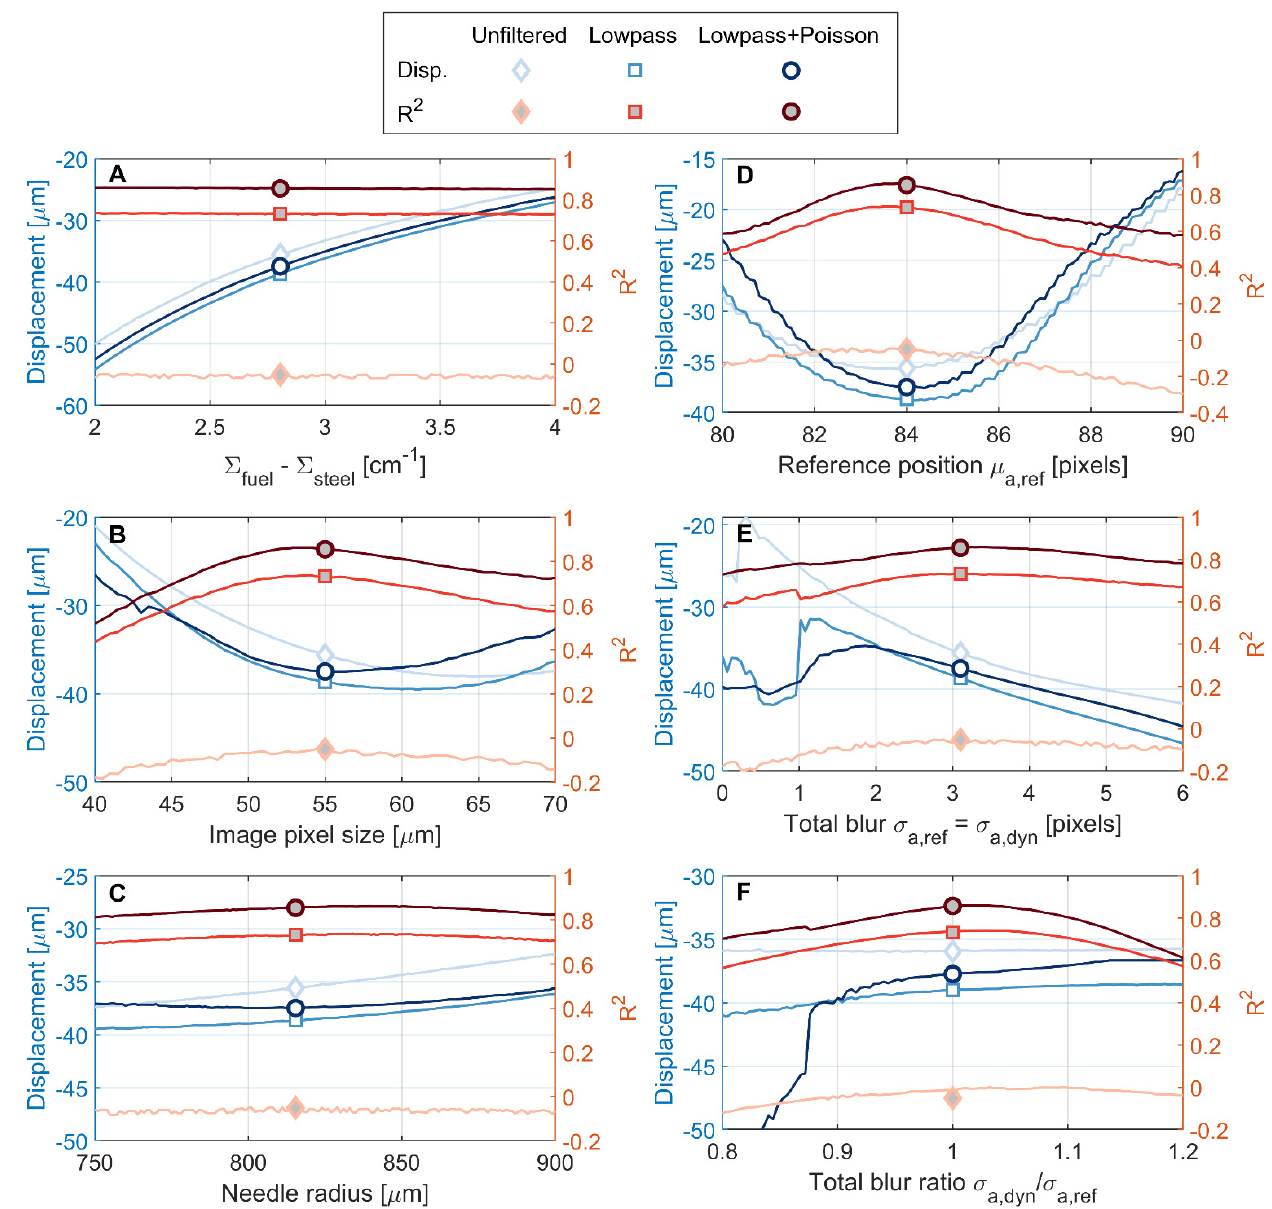
Figure A4. Effect of fit parameters on displacement prediction and fit quality. Fit parameters were independently varied at a high-displacement condition ( t = 2.27 ms). Symbols indicate fit parameters chosen for the time-series displacement fitting. ( A ) Attenuation coefficient difference has a large effect on predicted displacement but no impact on R 2 . Image pixel size ( B ) and injector needle radius ( C ) together set the scaling used in the model, and the peaks in R 2 for both parameters are near the values obtained from scale measurements with low sensitivity in predicted displacement at those values. ( D ) Reference position (nominal needle center) has clear R 2 peak and low sensitivity in predicted displacement at same value. ( E ) With reference and dynamic total blur set as equal, the filtered cases exhibit an R 2 peak and mild sensitivity in predicted displacement. ( F ) Varying the ratio of dynamic to reference total blur does not provide compelling evidence for a value greater than unity.